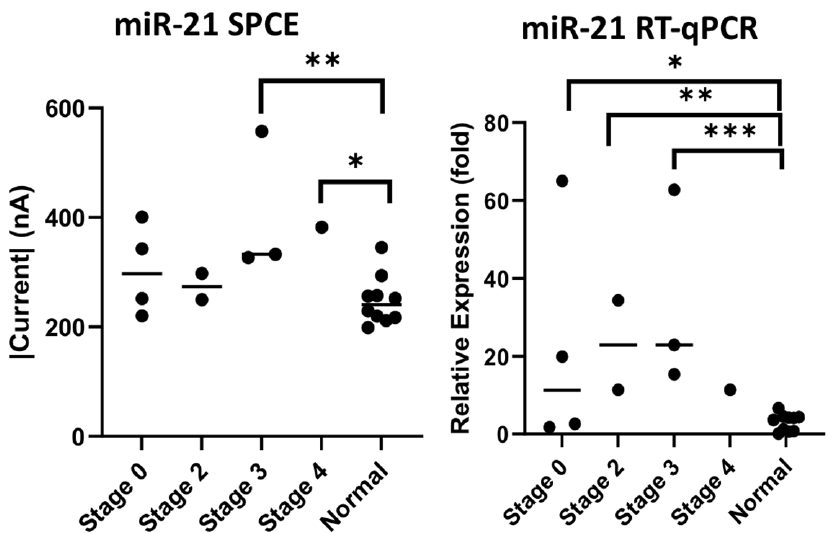
Figure 9. Measurement of miR-21 by cancer staging through miR-21 SPCE and RT-qPCR. * p -value < 0.05, ** p -value < 0.005, *** p -value < 0.0001.